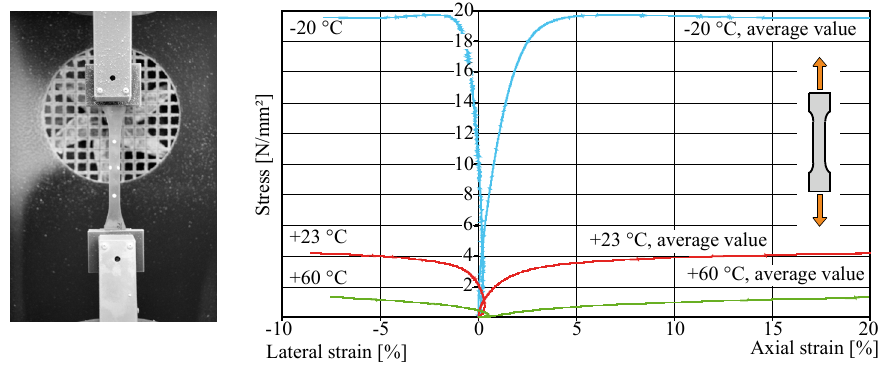
Figure 4: Tensile test for determining the material parameters, test set-up and